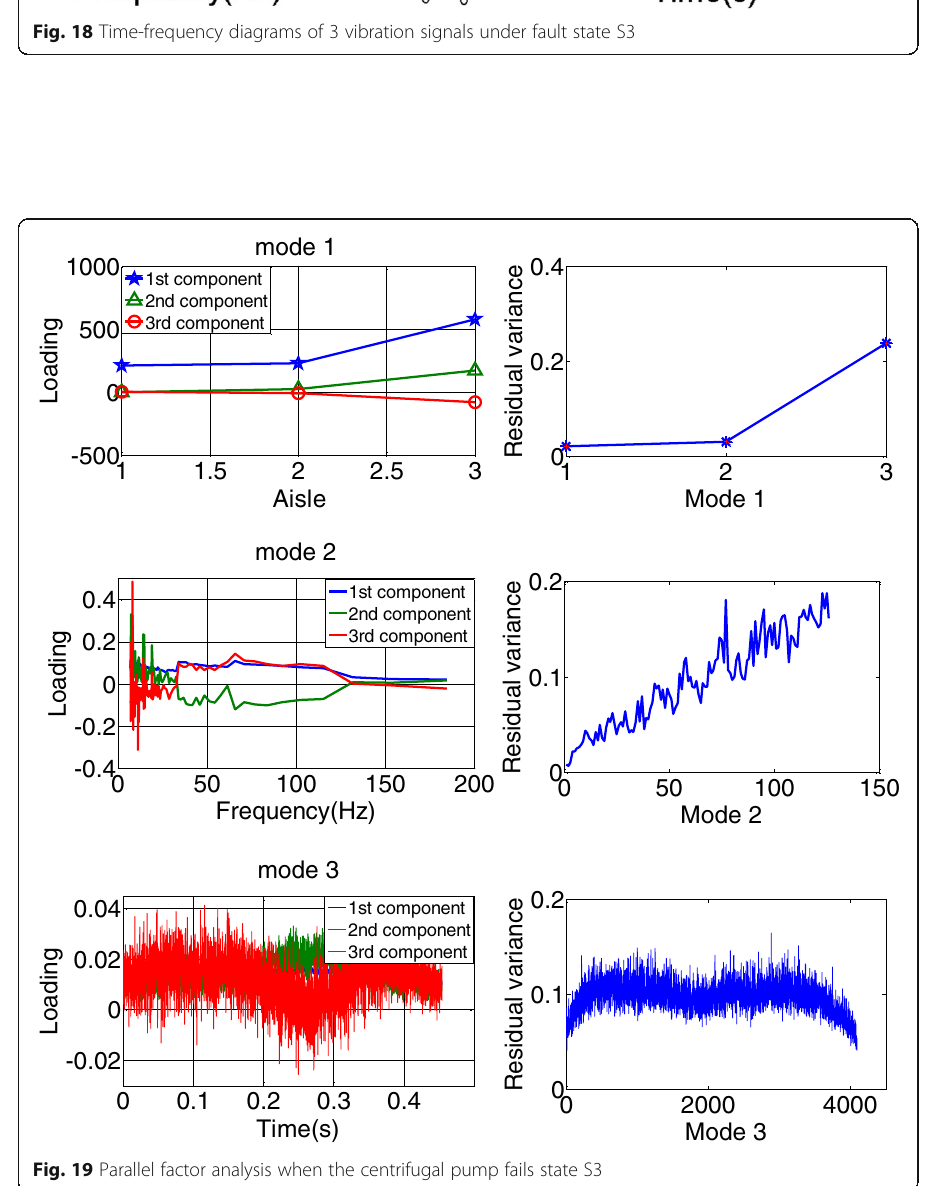
Fig. 19 Parallel factor analysis when the centrifugal pump fails state S3